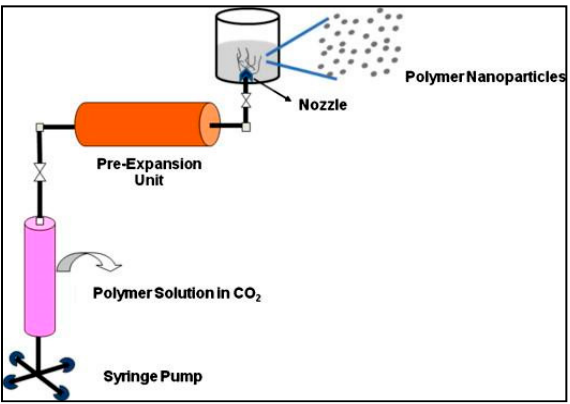
Figure 8. Experimental set-up for the rapid expansion of supercritical fluid solution into liquid solvent process. Reprinted with permission from Reference [73]. Copyright 2011 Elsevier.